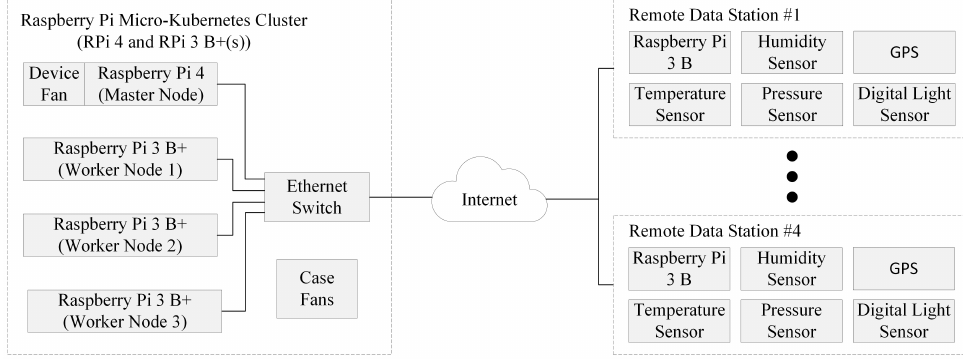
Figure 1. IoT system for mosquito research applications